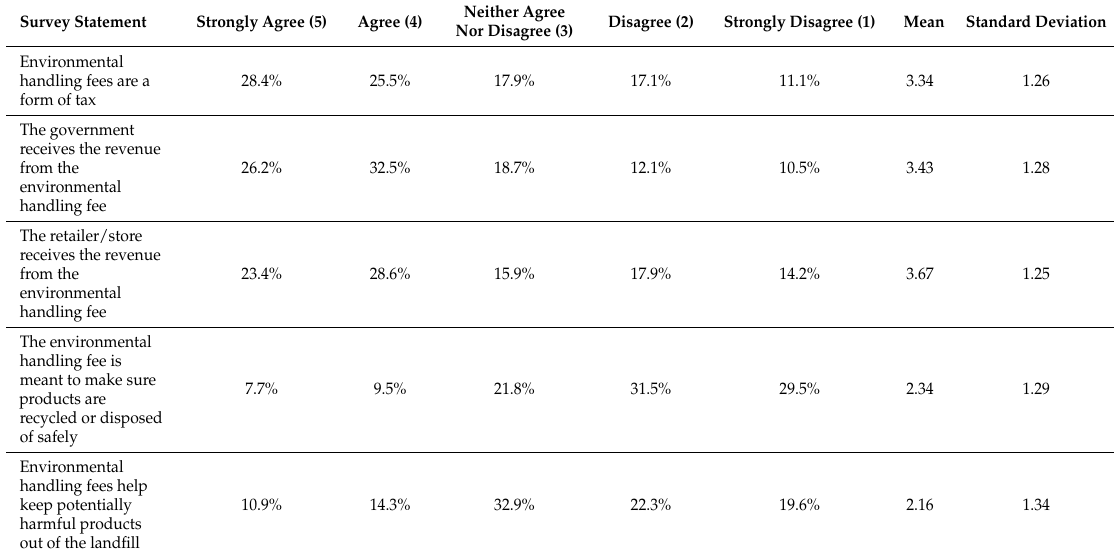
Table 5. General perception of environmental handling